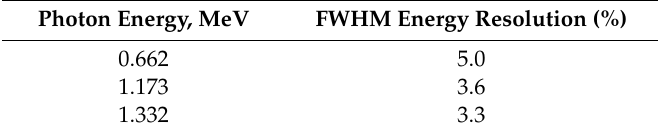
Table 1. Gamma ray FWHM energy resolution of the CLYC sensor.